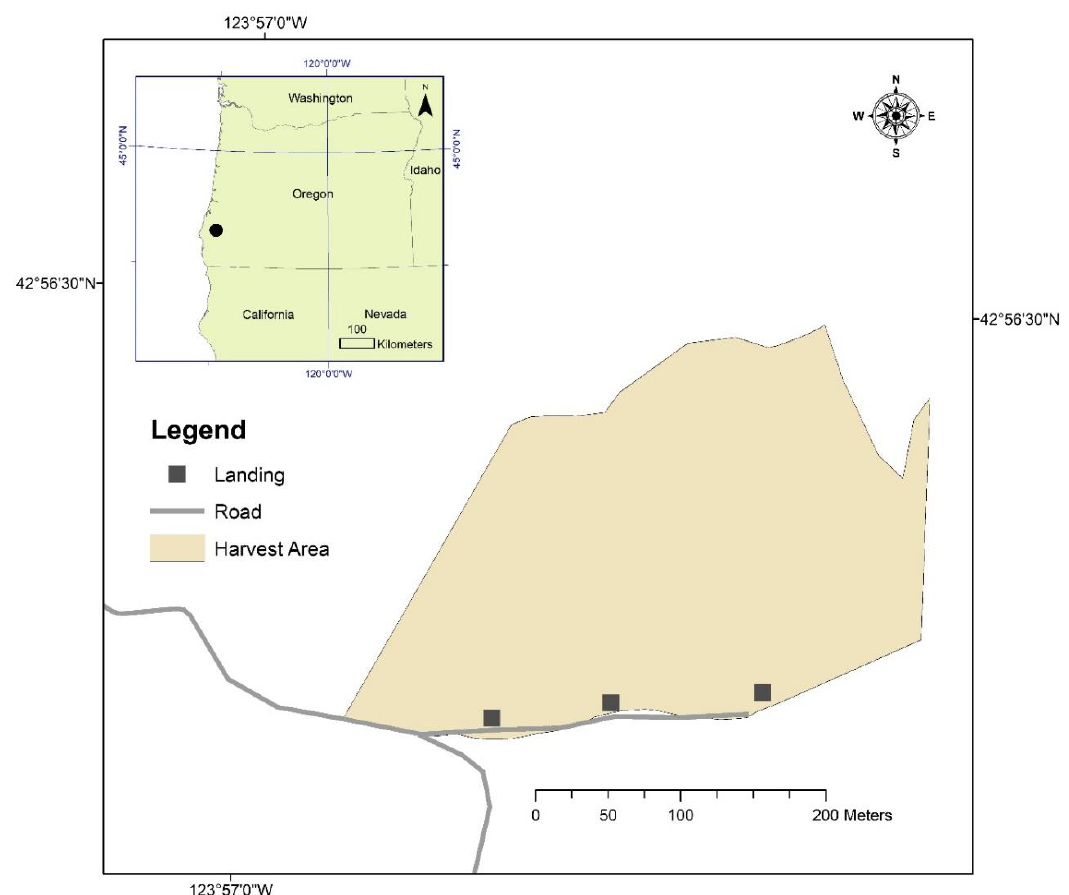
Figure 1. Harvest unit and landings for the study done to understand the system balance and operational phase interaction using work sampling techniques in Coos County, OR, USA. 135